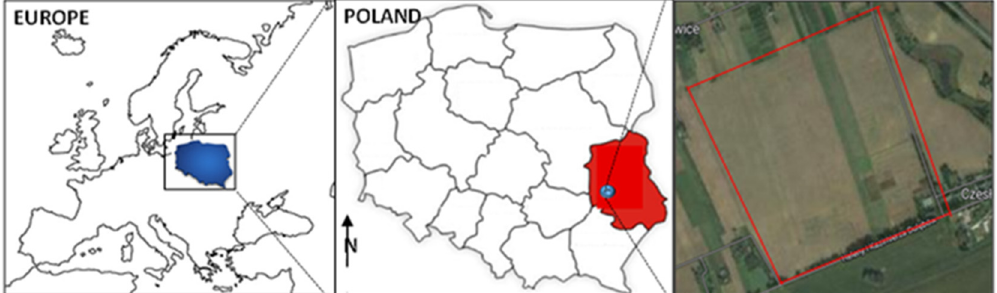
Figure 1. Location of the research area against the background of Europe, Poland and Lublin Region; red lines mark the area of Experimental Farm in Czes ł awice.